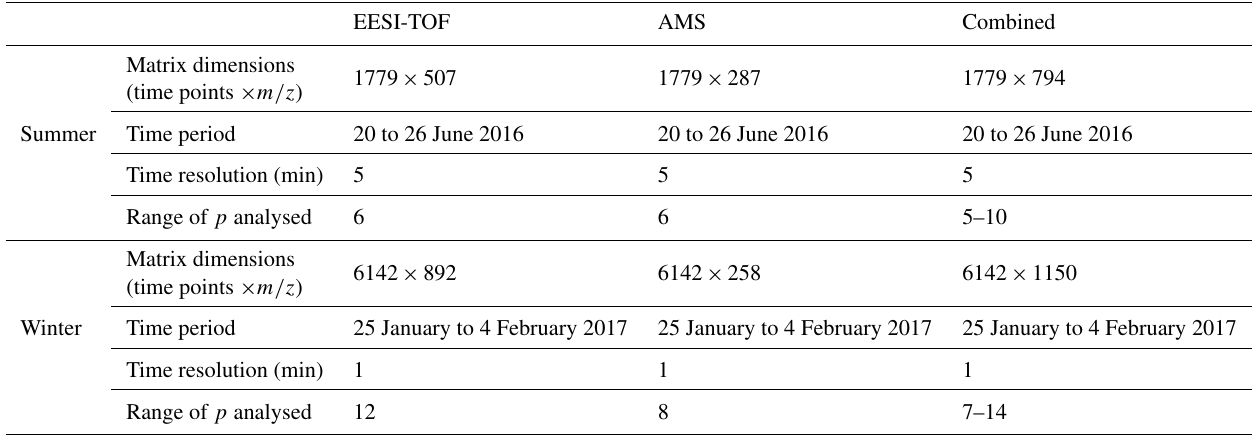
Table 1. Summary of parameters for the PMF analysis of re-analysed summer and winter datasets and the combined dataset. There are 257 ions that are found in PMF input matrices for both the summer and winter datasets (common ions are listed in the Table S1 in the Supplement). All datasets include AMS measurements of NO + and NO + 2